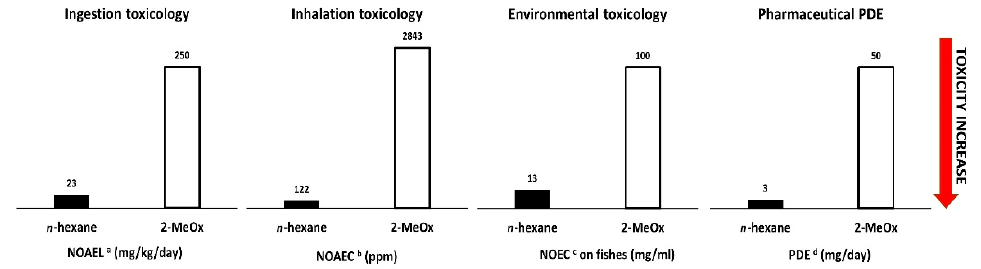
Figure 2. n -hexane and 2-MeOx Ingestion, Inhalation and Environmental toxicities and Pharmaceutical PDE comparison. a NOAEL—no-observed-adverse-effect level [28,29]; b NOAEC—no-observed-adverse-effect concentration [30,31]; c NOEC—no-observed-effect concentration [32,33]; d PDE—permitted daily exposure for an average human of 50 kg